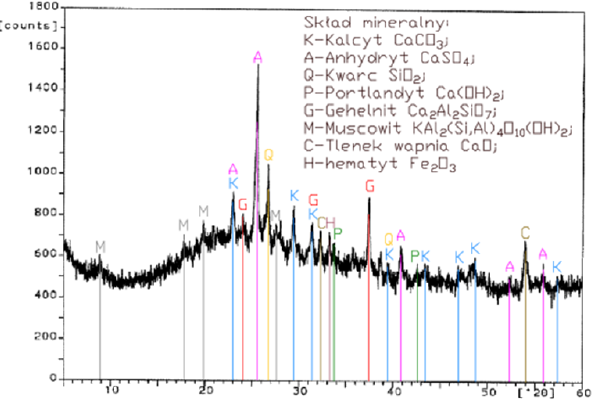
Figure 2. XRD pattern of fluidized bed combustion fly ash from combustion of lignite (FBC I).